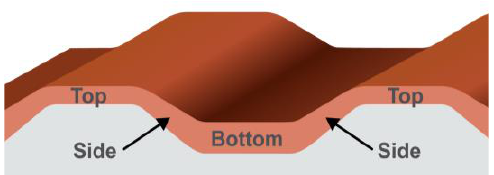
Figure 1. Schematic image of an iron layer on a substrate period.